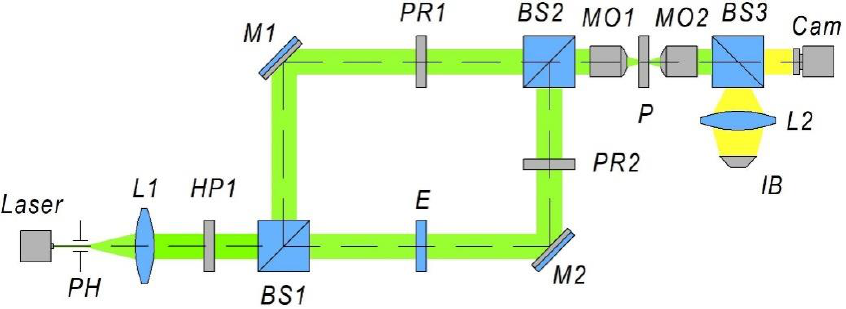
Figure 5. Schematic of the optical setup used in the